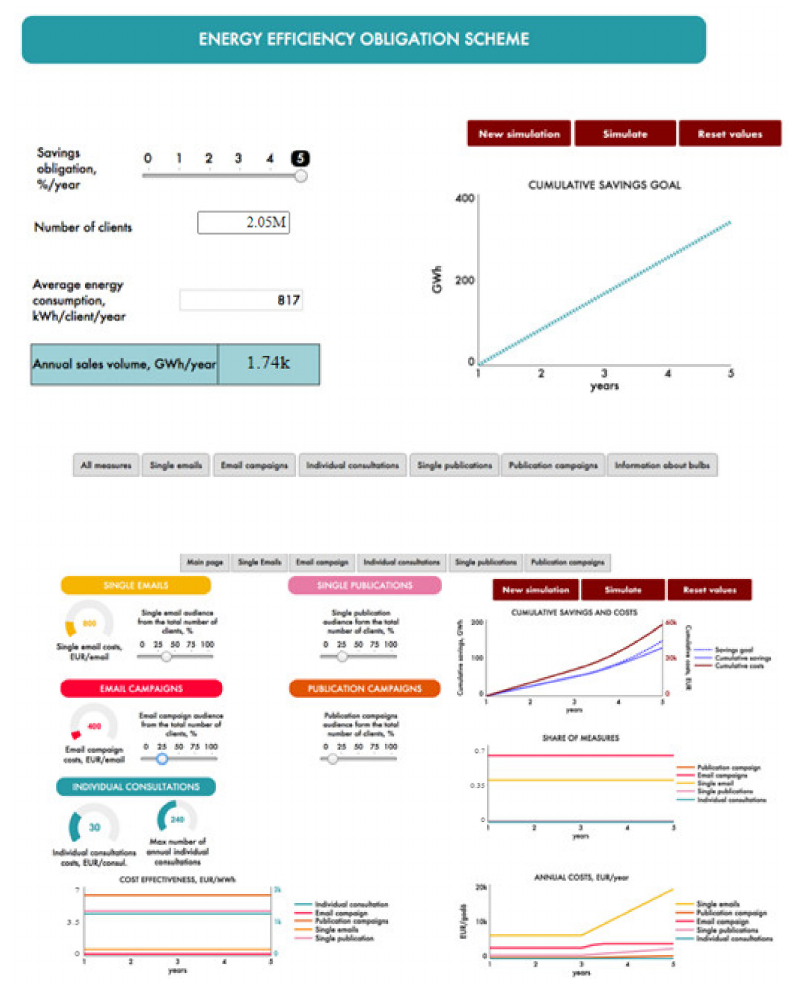
Figure 7. The second page of the interface of all measures as defined by the